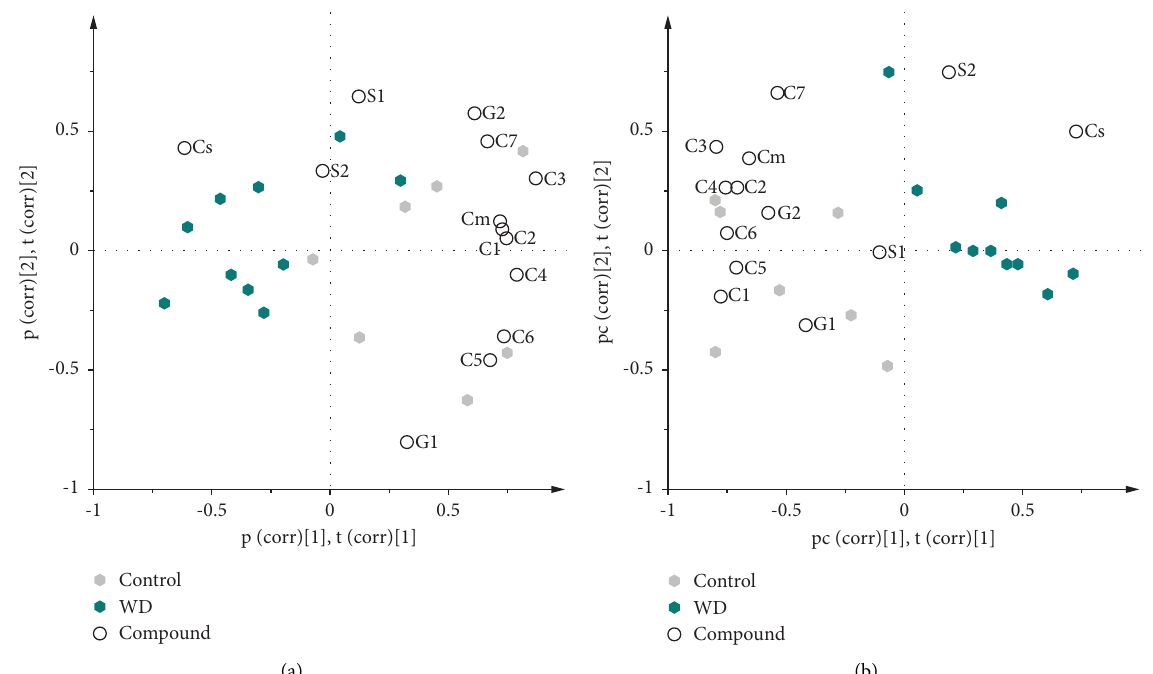
Figure 4: Multivariate analysis separated the Western diet (WD) fed male LDLr − / − ApoB 100/100 mice into low xenobiotic metabolism activity group in contrast to mice fed with the chow diet. Biplots showing the frst two latent components of the principal component analysis ((a) cumulative R 2 X � 0.99 and cumulative Q 2 � 0.58) and a partial least sum of squares discriminant analysis ((b) cumulative R 2 Y � 0.86 and cumulative Q 2 � 0.66) of CYP oxidation, glucuronidation, sulfonation, and COMT activities in liver of control and WD male LDLr − / − ApoB 100/100 mice. Explanations of the symbols: C1 � ethoxyresorufn 7-(O)-deethylation, C2 � 7-hydroxylation of 3-(4-tri- fuoromethoxyphenyl)-6-methoxycoumarin, C3 � 7-hydroxylation of 3-(3-fuoro-4-hydroxyphenyl)-6-methoxycoumarin, C4 � coumarin 7-hydroxylation, C5 � pentoxyresorufn 7-(O)-depentylation, C6 � 7-hydroxylation of 3-(3-methoxyphenyl)coumarin, C7 � 7-(O)-deme- thylation of 3-(3-benzyloxo)phenyl-7-methoxycoumarin, G1 � HFC glucuronidation, G2 � 3-(1H-1, 2, 4-triazol-1-yl)-7-hydroxycoumarin glucuronidation, S1 � HFC sulfonation, S2 � 3-(4-methylphenyl)-7-hydroxycoumarin sulfonation, Cs � cytosol COMT, and Cm � mi- crosomal